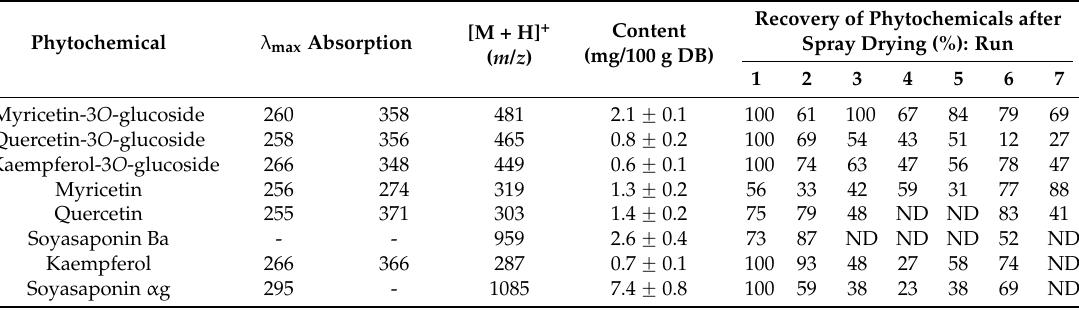
Table 2. Phytochemical composition of lyophilized black bean extract and recovery percentage after spray drying using different amounts of total solids and maltodextrin.